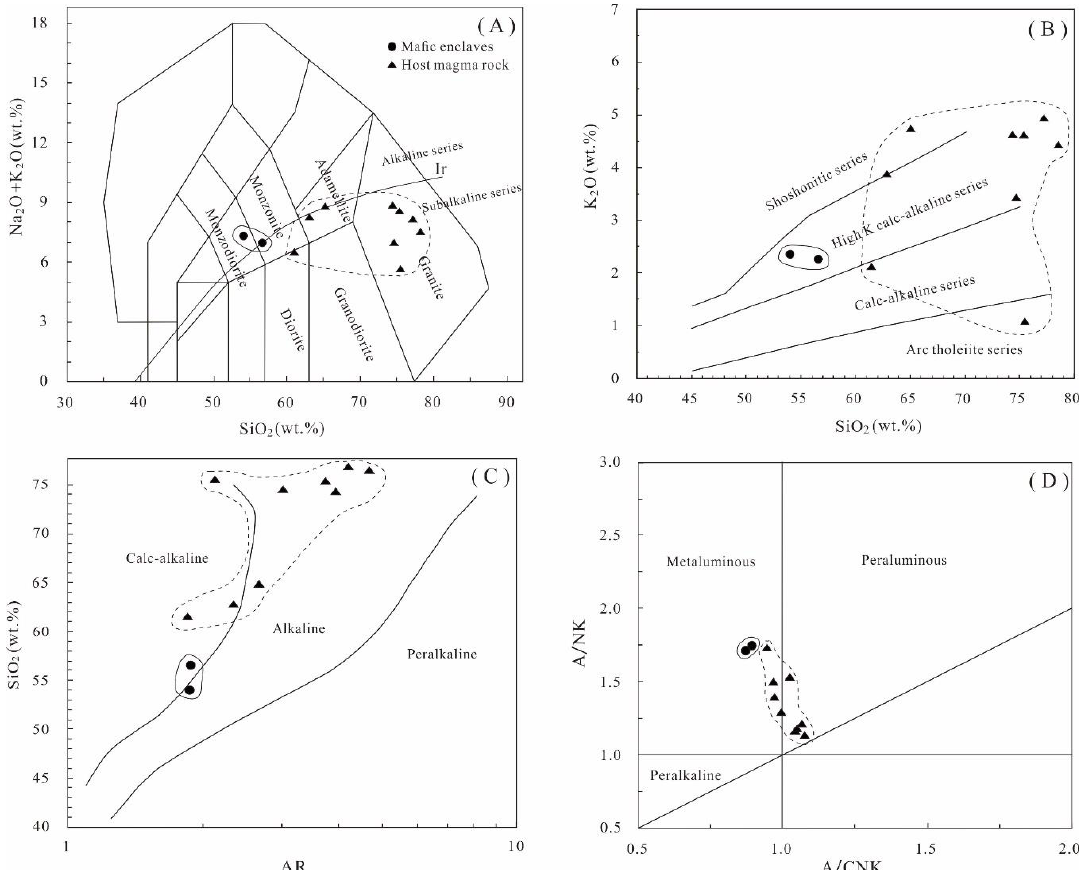
Figure 5. Scatter plots of the geochemical characteristics of the mafic enclaves and the host rock. ( A ) SiO 2 − (K 2 O + Na 2 O) diagram (after Middlemost [27]). ( B ) SiO 2 -K 2 O diagram (after Peccerillo and Taylor [28]). ( C ) AR-SiO 2 diagram (after Wright [29]). ( D ) A/CNK-A/NK diagram (after Maniar and Piccoli [30]).